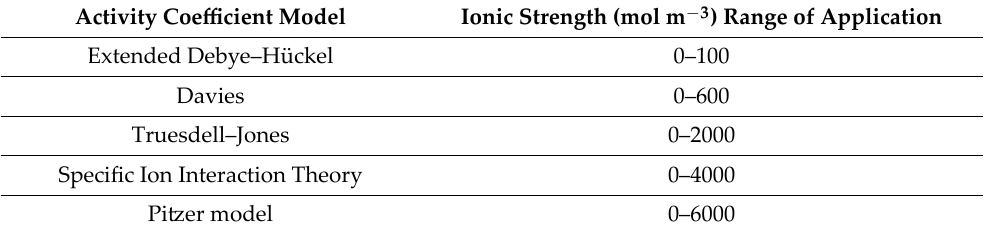
Table 3. The usable ranges of the most popular models of activity coefficient [14], quoted after [15]. Activity Coefficient